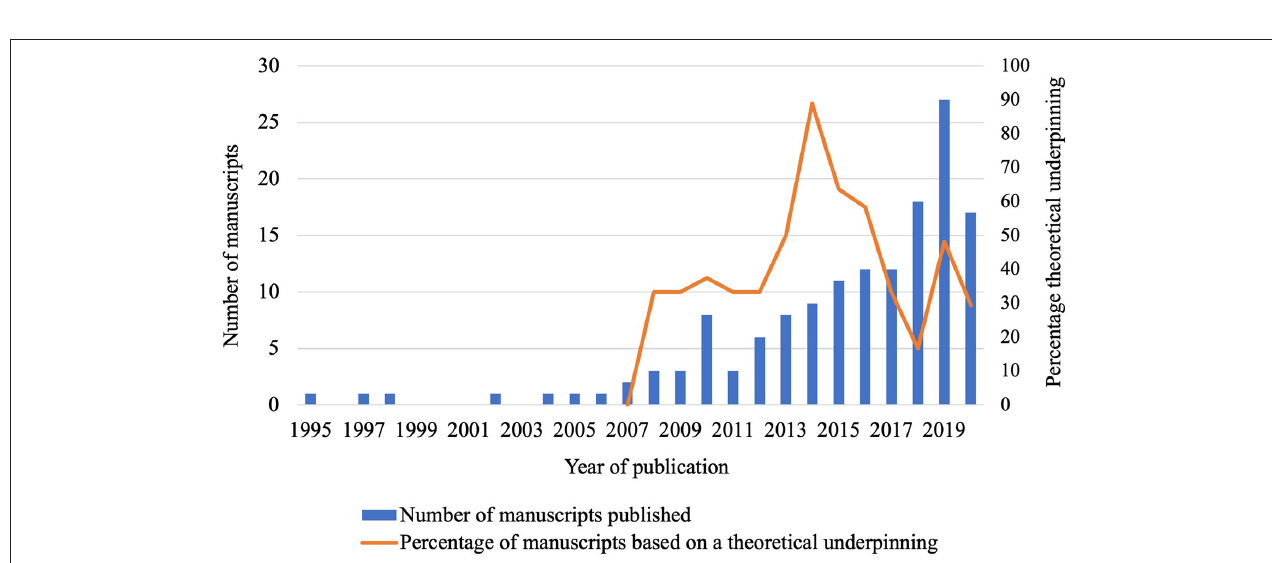
FIGURE 4 | Manuscripts about farmers’ behavior regarding cattle diseases published (Pubmed or Web of Science) between 1995–2020, and the subset based on a theoretical underpinning.